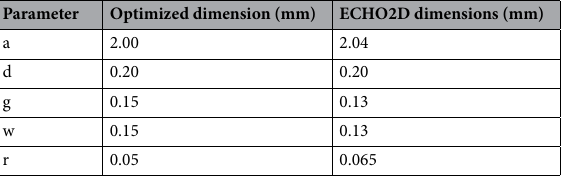
Table 1. Optimized structure dimensions and structure dimensions for ECHO2D